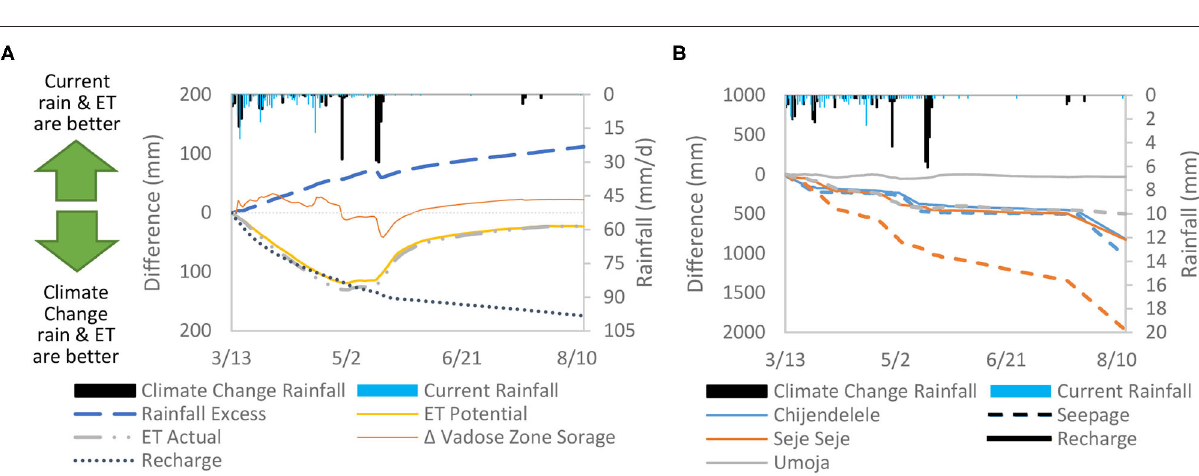
Frontiers in Water |